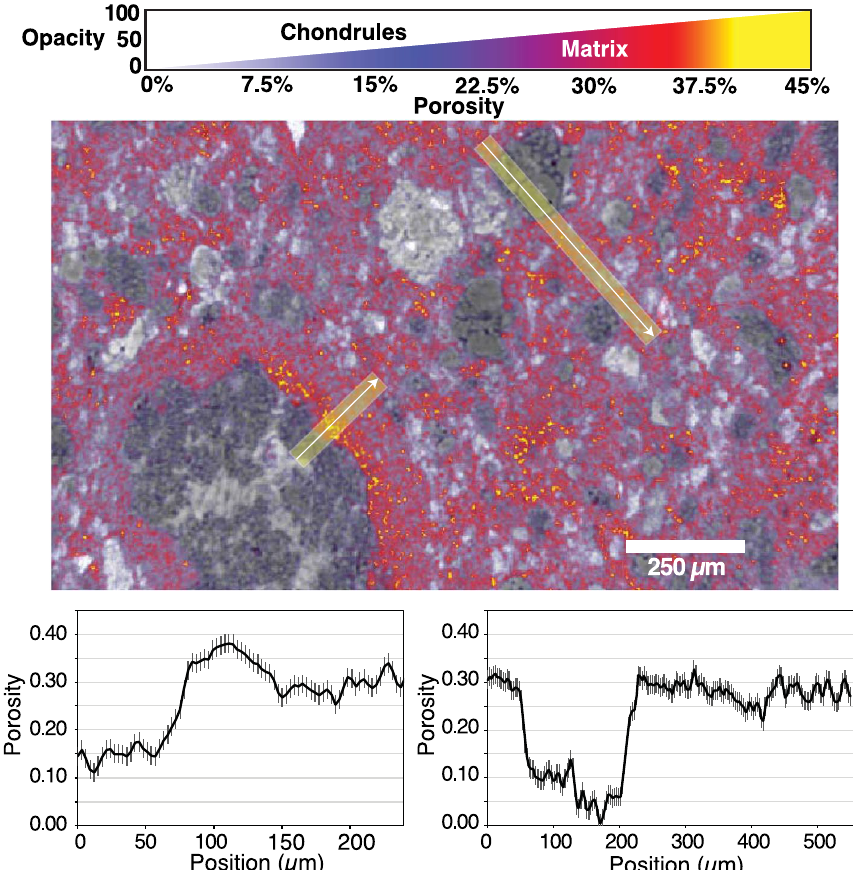
Figure 4. XCT Slice 706 of porosity volume. (Top) Porosity data (colorized with variable opacity) overlaid on XCT data of Air scan (greyscale) showing the distribution of porosity. Porosity value indicated is that inside an individual voxel. White lines with yellow shaded regions show location of line profile plots below. (Bottom) Line profile plots of porosity using 15-pixel wide average (yellow regions on lines in top image) with vertical bars representing the standard error of the mean (2.1%). The matrix has a relatively higher porosity (22–34%) compared to the chondrules (< 17%), and some FGR areas have even higher porosity (up to 38%) than the matrix. See Supplemental Material for animation of full porosity